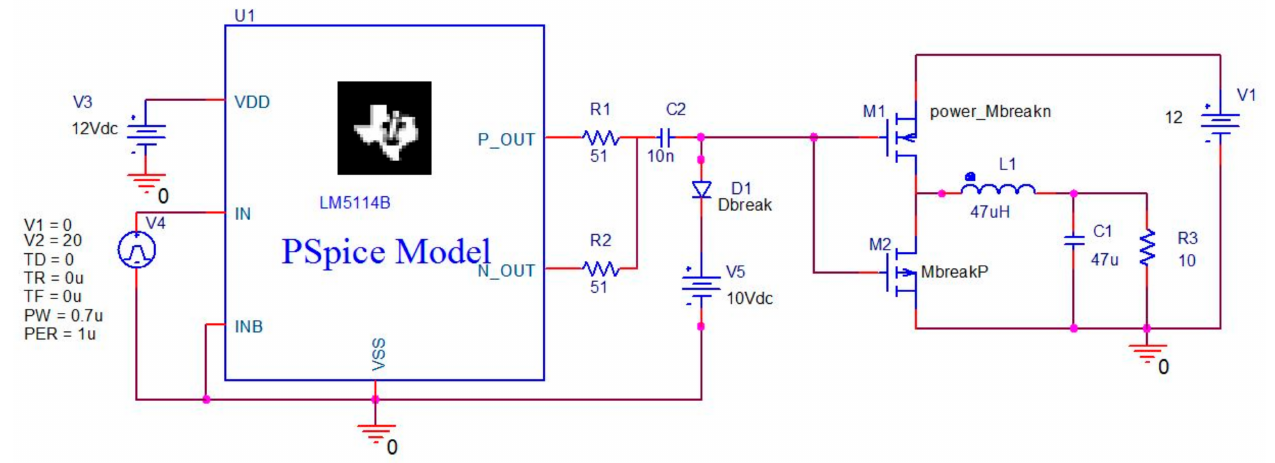
Figure 15. SPICE simulation model for the synchronous buck converter.